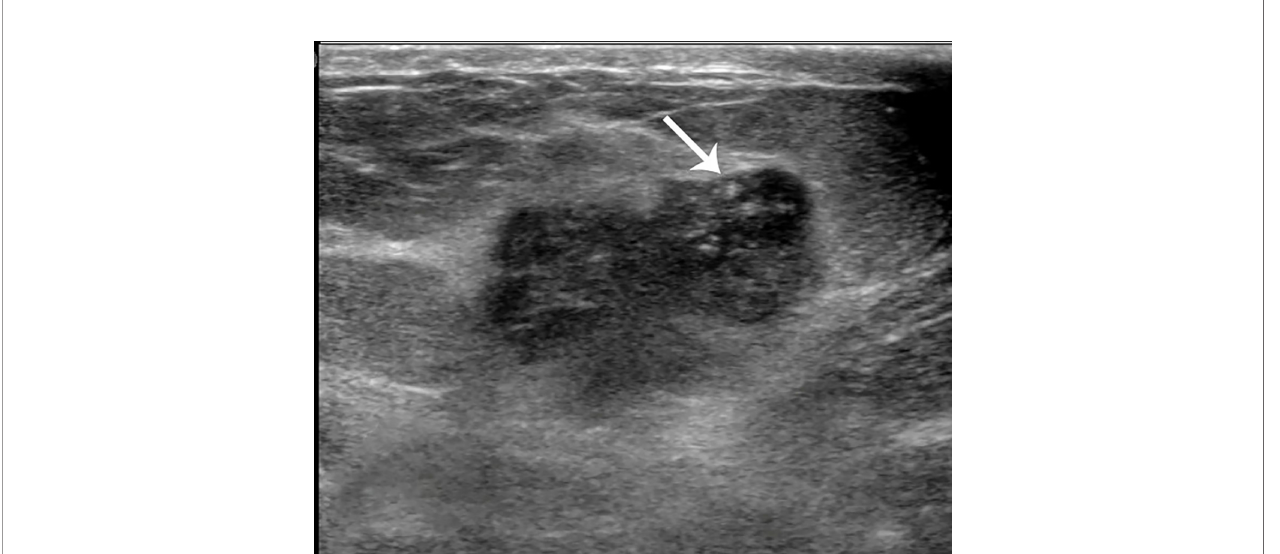
FIGURE 4 | Case 2: A 55-year-old woman with mixed mucinous breast carcinoma (MMBC) presented with a hypoechoic mass (1.9 × 1.6 × 1.5cm) in the right breast. The mass presented with an irregular shape and some punctate calci fi cations (white